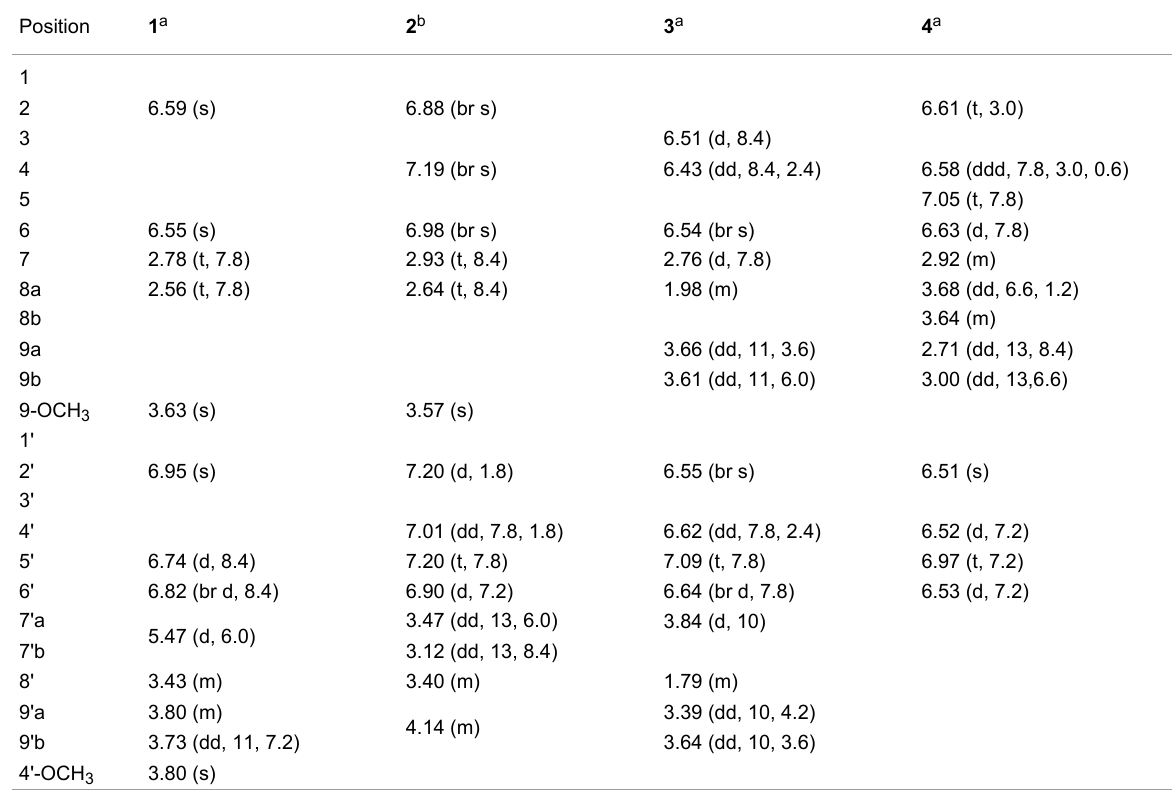
Table 1: 1 H NMR data for compounds 1 – 4 ( δ , ppm, and coupling constant J in